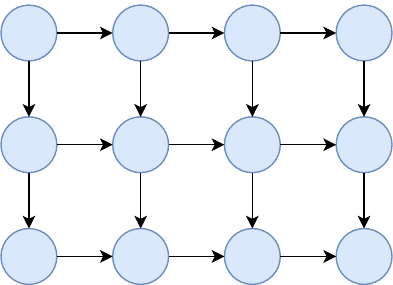
FIG. 11. A cluster state in a Bayesian quantum circuit. A cluster is generated from initial state jþi ⊗ n by applying control-Z gates between each pair of neighbors on a square lattice. We may assign each edge an arrow in the way shown in this figure in order to get a directed acyclic graph. We can see that this circuit is a Bayesian quantum circuit by checking Definition 1 and noticing that, in a control-Z gate, there is no need to distinguish between control and target